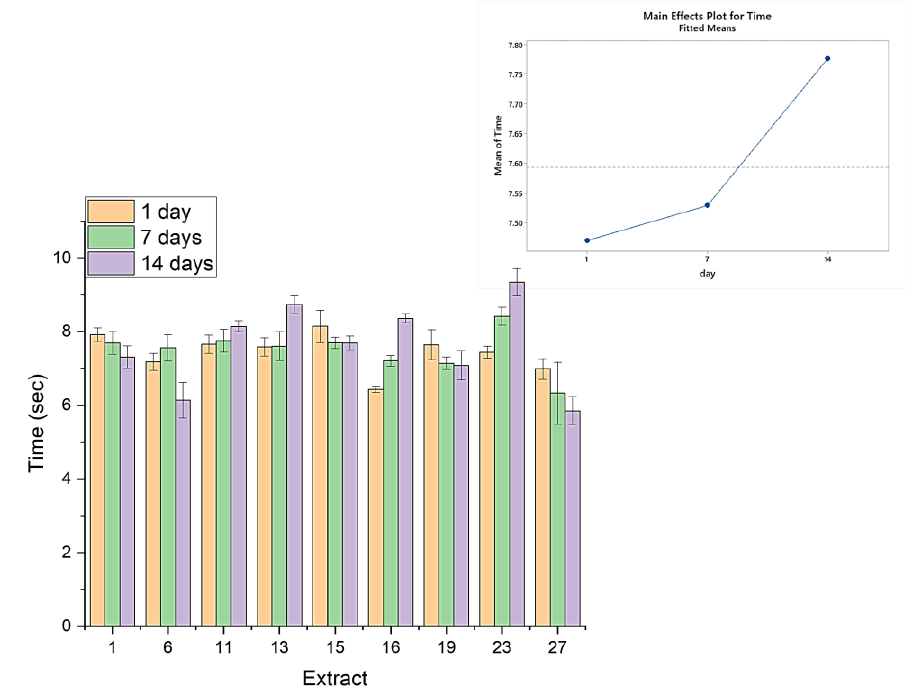
Figure 4. Filament breakup time of yogurts in the first day, as well as after one and two